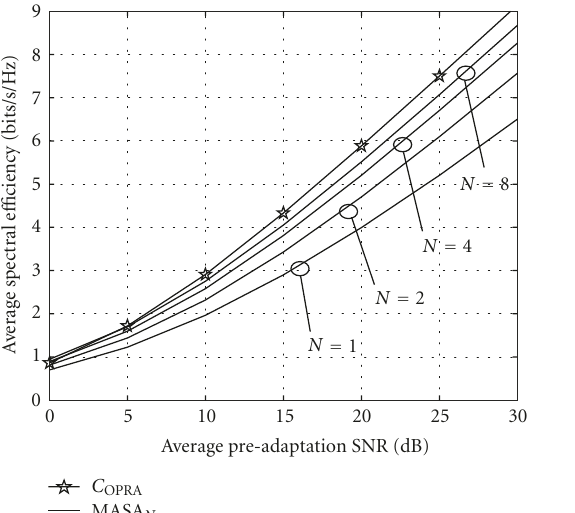
(b) Average spectral e ffi ciency of MASA N × K as a function of γ , for four MASA schemes with N × K = 8 Figure 5: Average spectral e ffi ciency of di ff erent MASA schemes.